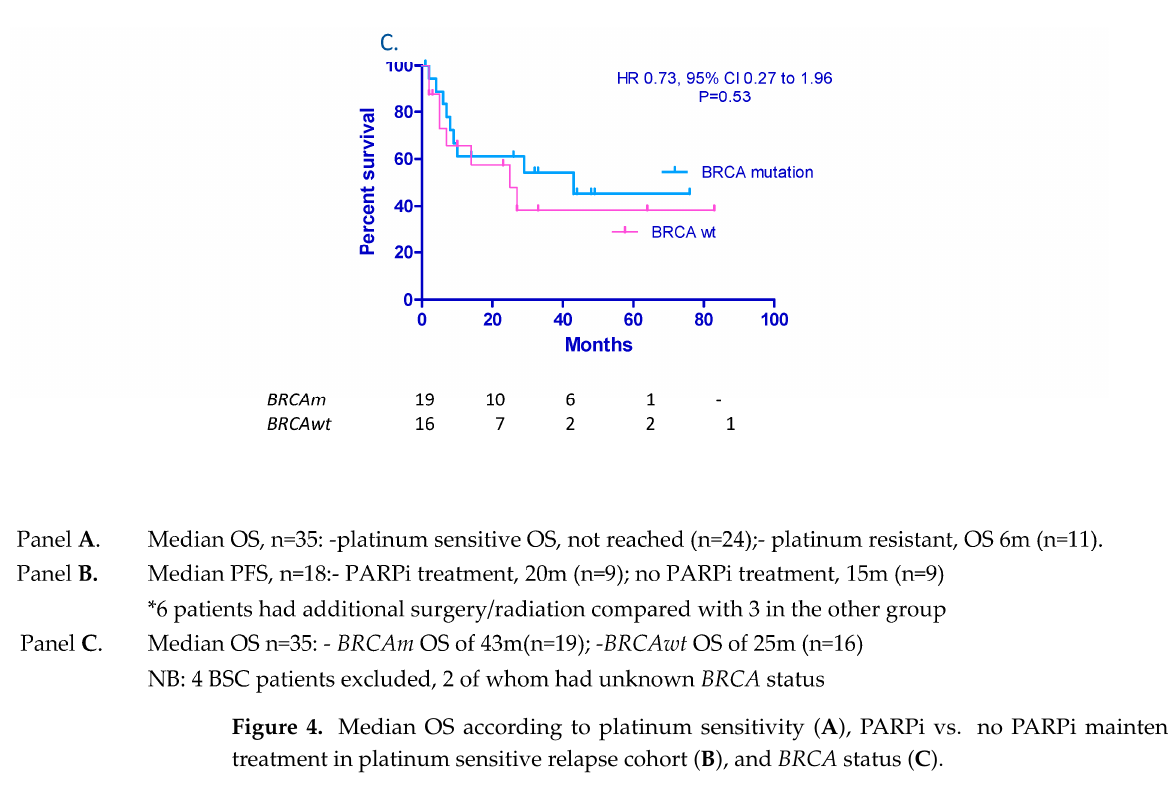
Table 3. Median OS in relation to number of treatment modalities received for BM. NB: 13/14 those receiving PARPi for BM were first platinum-sensitive relapse, compared with 5/21 who did not receive PARPi for BM at first